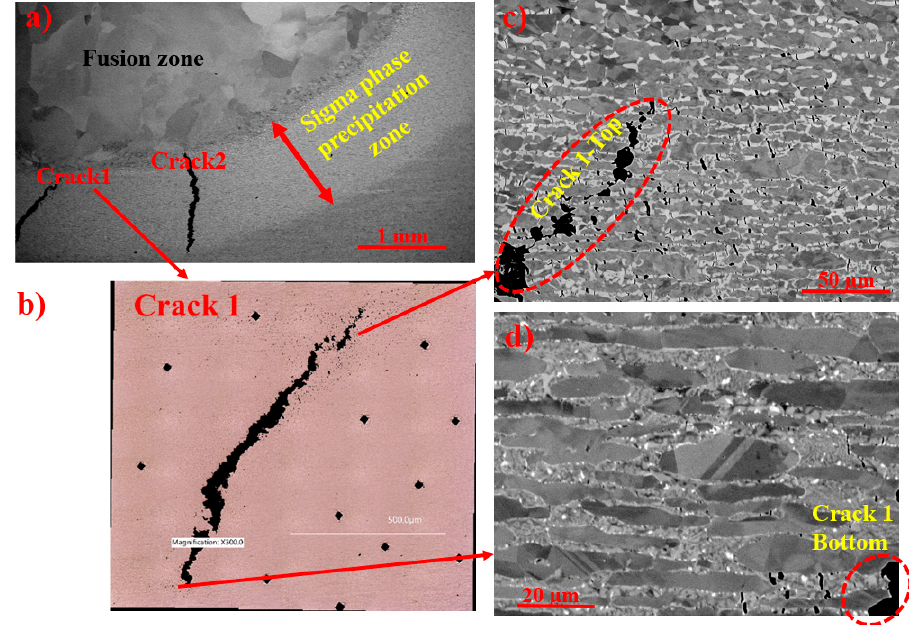
Figure 10. ( a ) Bright etching σ precipitation band, with two macroscale cracks. ( b ) Optical micrograph